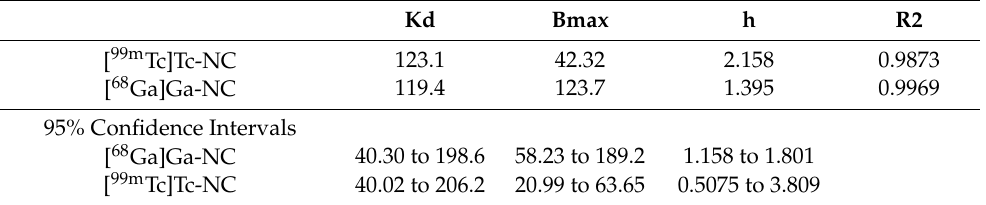
Table 1. Kd, Bmax and h-values obtained from [ 99m Tc]Tc/[ 68 Ga]Ga-NC saturation binding experi- ments.